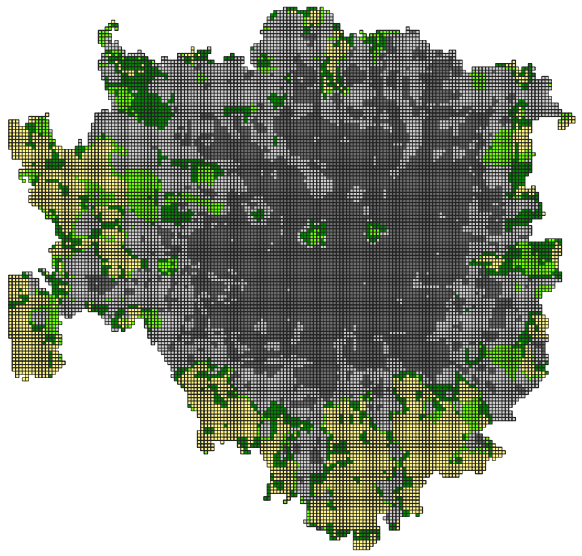
Figure 3. Map of monthly climate data from 2017 with 5 clusters